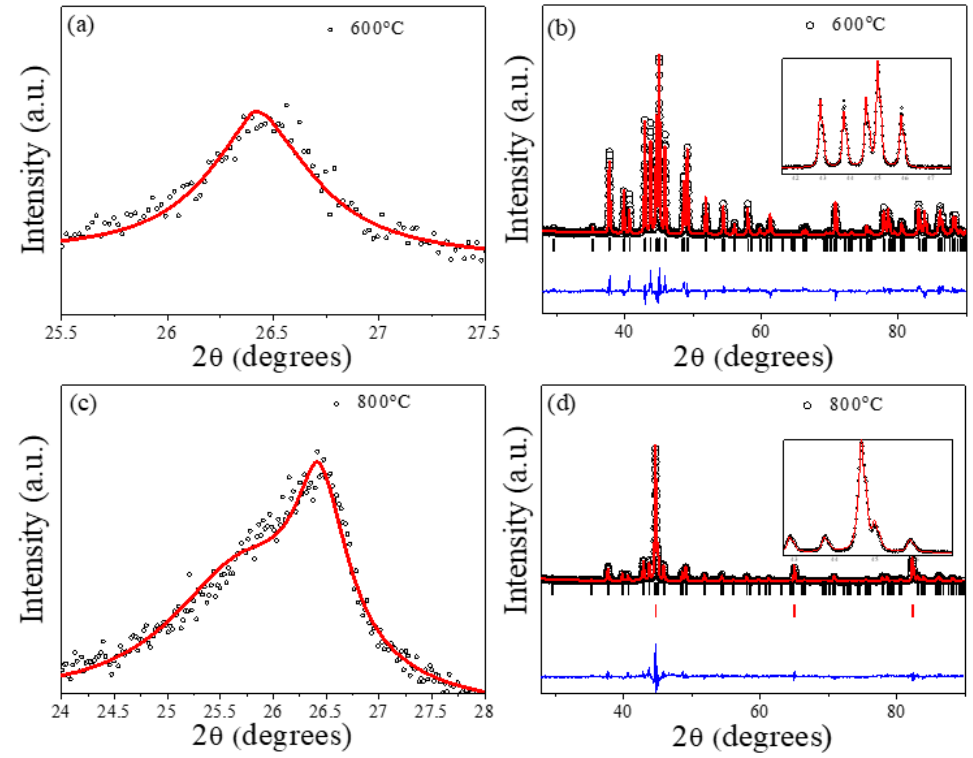
Figure 3. XRD patterns for the MNPs + fructose samples annealed at different temperatures: ( a ) and ( b ) T ann = 600 ◦ C: ( c , d ) T ann = 800 ◦ C. (o) Experimental, (—) calculated (Rietveld refinement) intensities and (—) difference between both intensities. The Bragg reflections are shown for ( | ) Fe 3 C and ( | ) α -Fe. Insets: enlargement for 42 ≤ 2 θ ≤ 48 region.